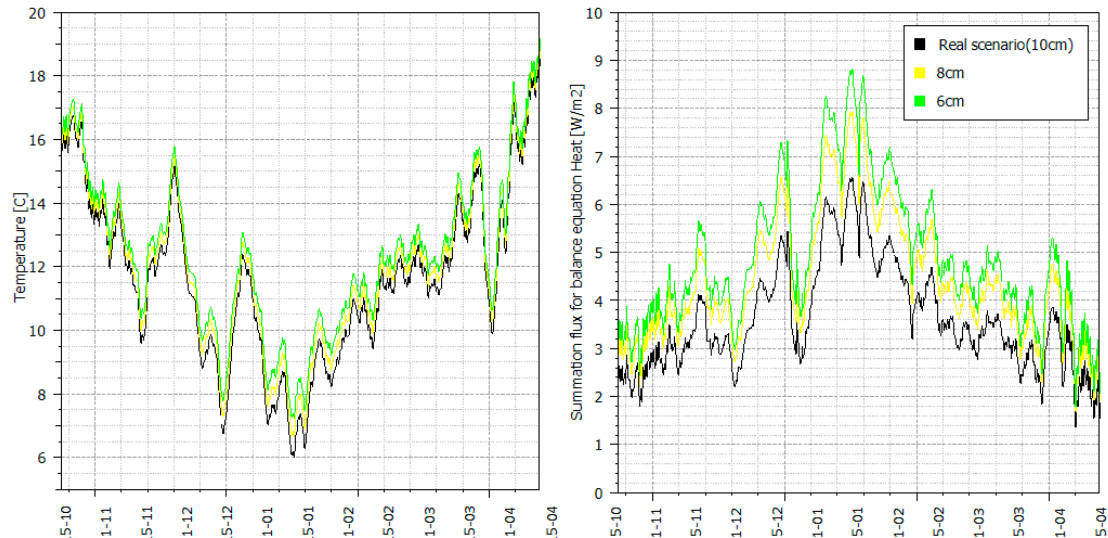
Figure 15. Left panel: hourly value of temperature in Point C (Figure 9). Right panel: hourly value of heat loss for the simulated walls, both during the heating period (15 October–15 April). Design scenarios of 6–8 cm of stone wool are included.